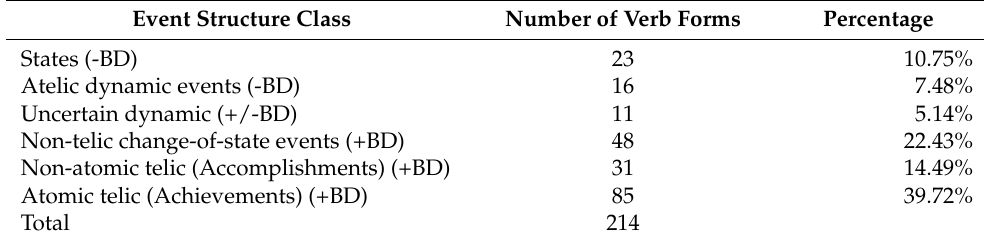
Table 4. Event structure classes in our corpus of zero-inflected verbs.